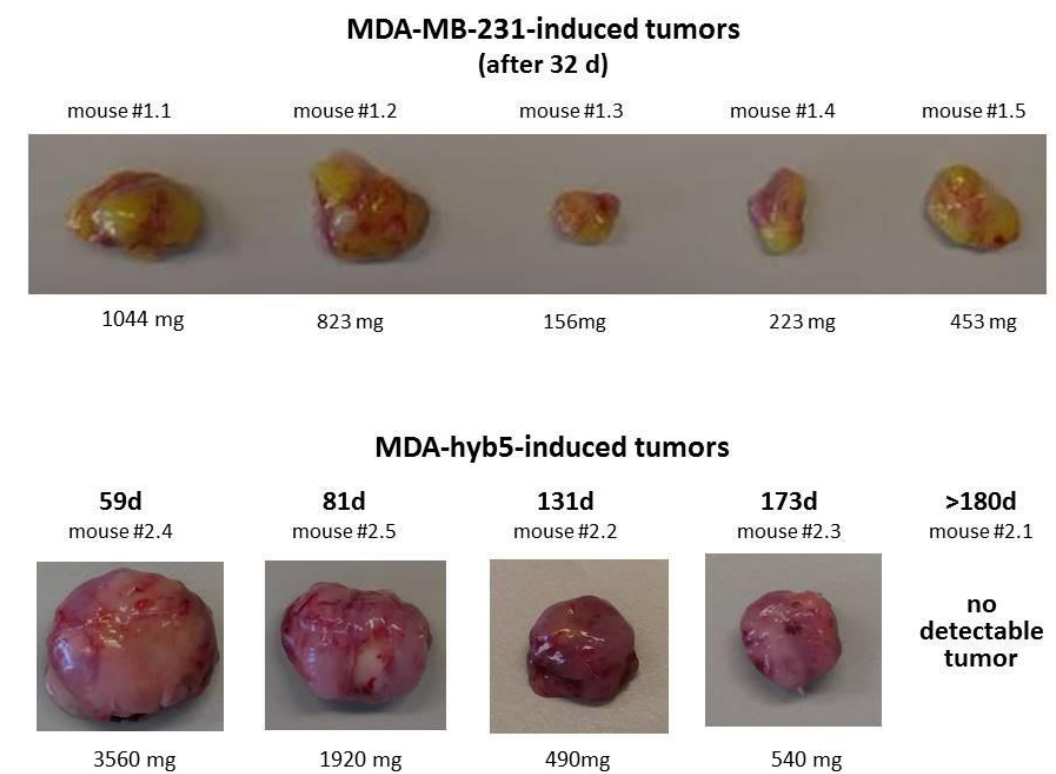
Figure 2. Tumors developed by subcutaneous injection of 2 × 10 6 MDA-MB-231 GFP or MDA-hyb5 cells were dissected from NODscid mice at the indicated time points and weighted.